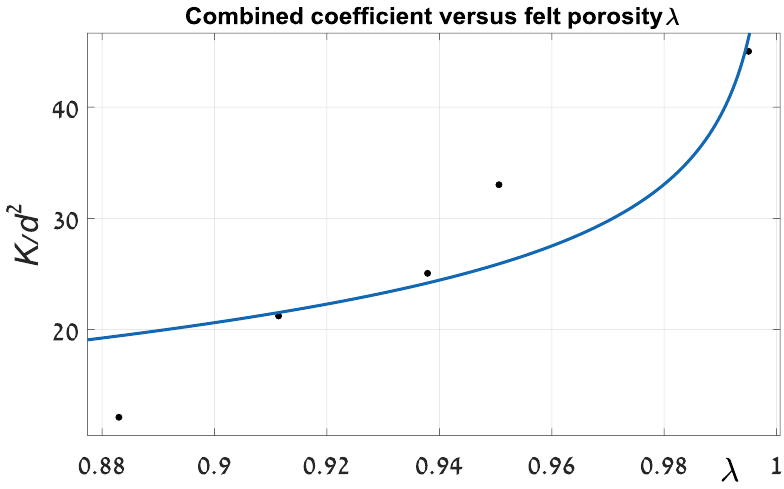
Figure 5. Combined coefficient k / d 2 versus felt porosity λ .